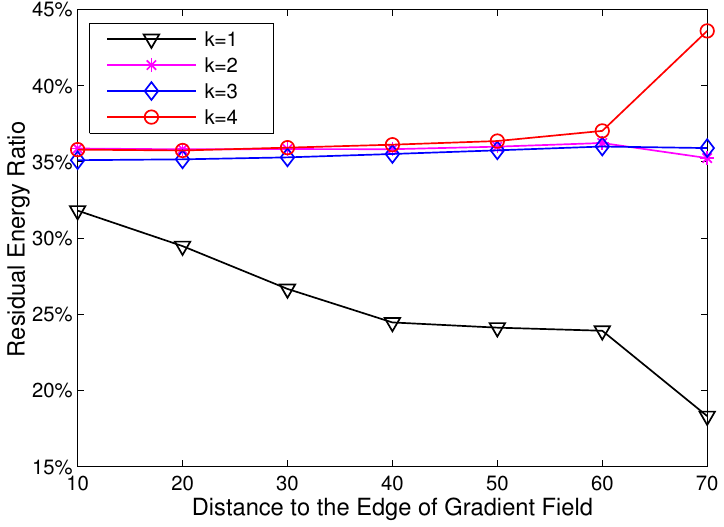
Figure 7. Residual energy ratio with different node locations.